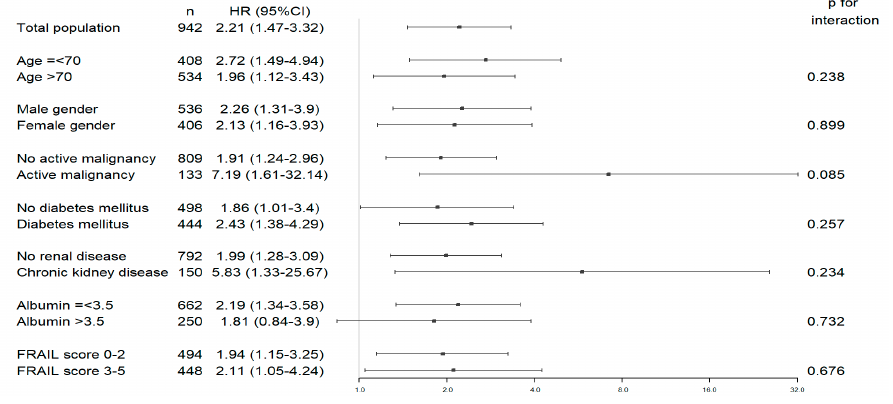
Figure 3. 30-days readmission according to serum ALT activity.